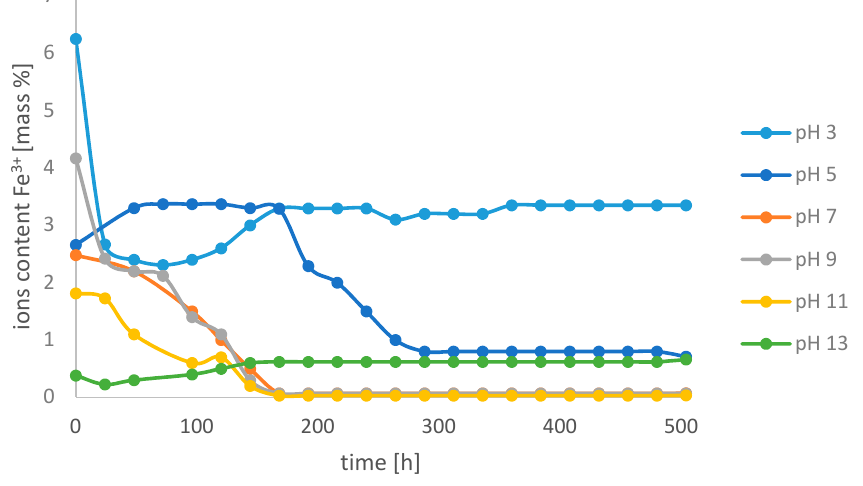
Figure 7. Change in the content of Fe 3+ ions over time at different pH values in the pH electrolyte environment in the iron(III) ethylenediamine- N,N ′ -di[(2-hydroxy-5-sulfophenyl)acetic acid] solution.